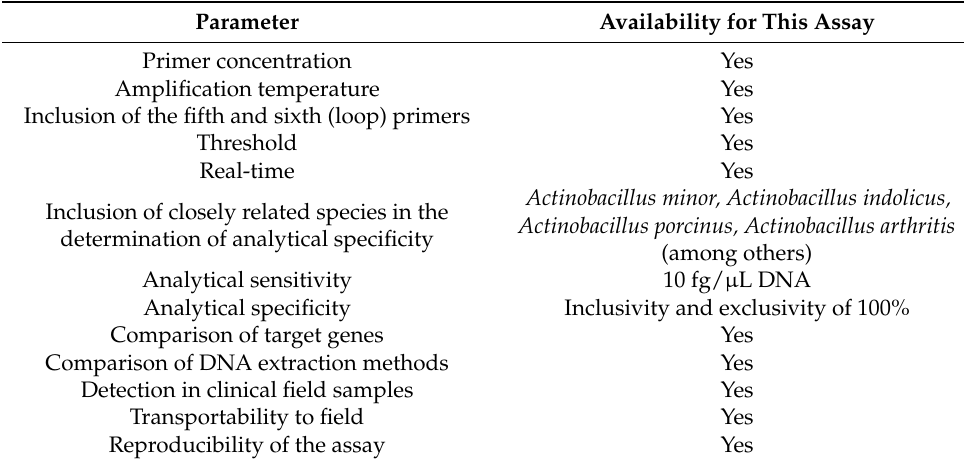
Table 7. The advantages of the developed LAMP